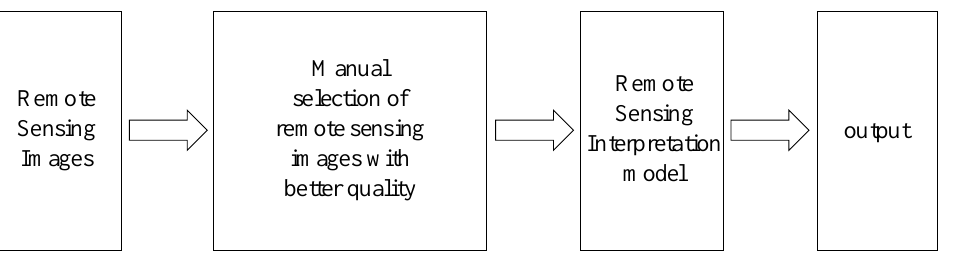
Figure 1. Remote sensing interpretation network training flow chart.